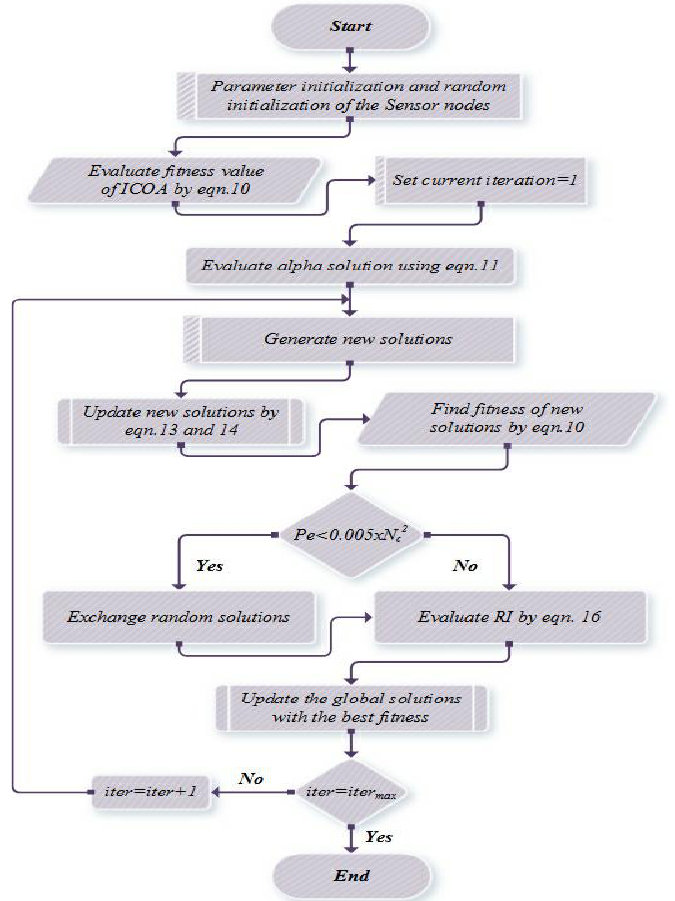
Figure 3. Flowchart for CH selection using ICOA.